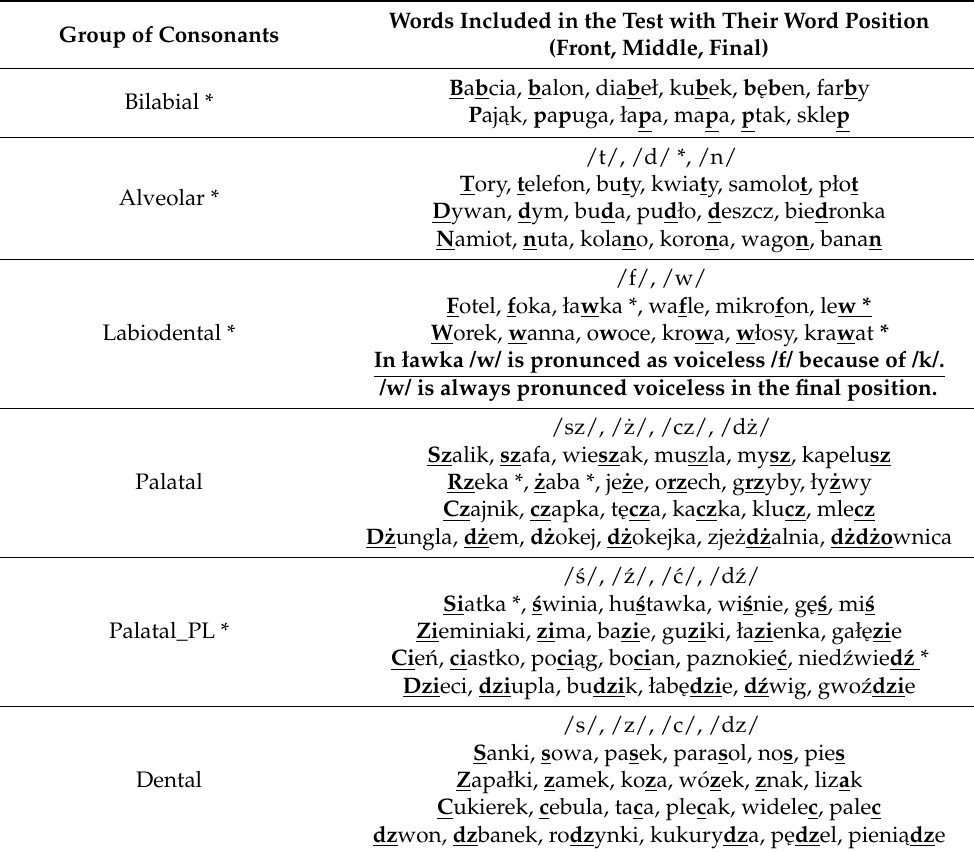
Table 3. The list of words included in the Articulation Test for Children and